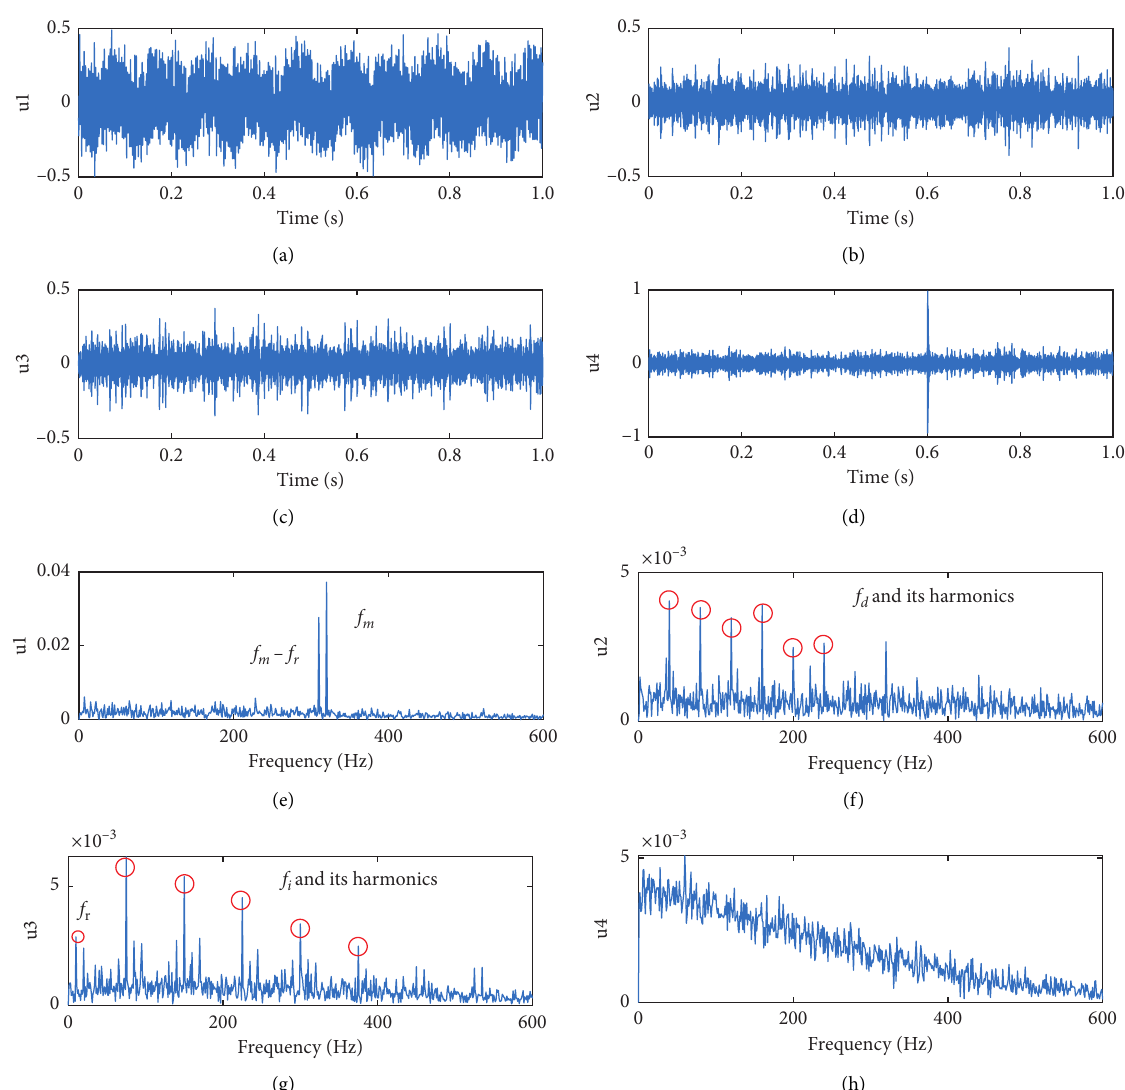
Figure 13: Simulated signals of case 2: signal processing results based on IPAVMD: (a–d) time-domain waveform of each mode and (e–h) the corresponding squared envelope